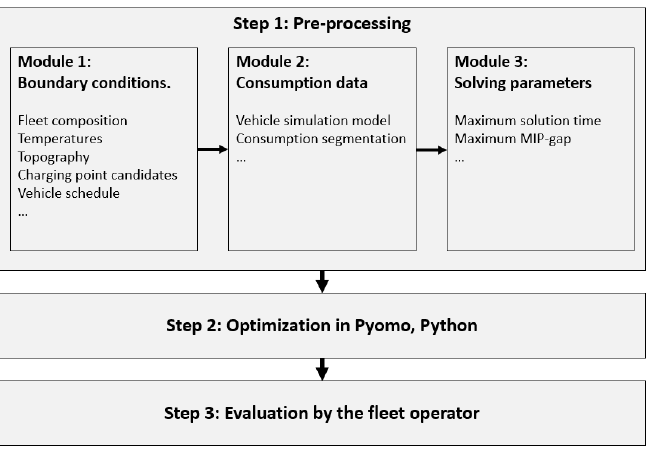
Figure 2. Schematic of the charging infrastructure optimization process.